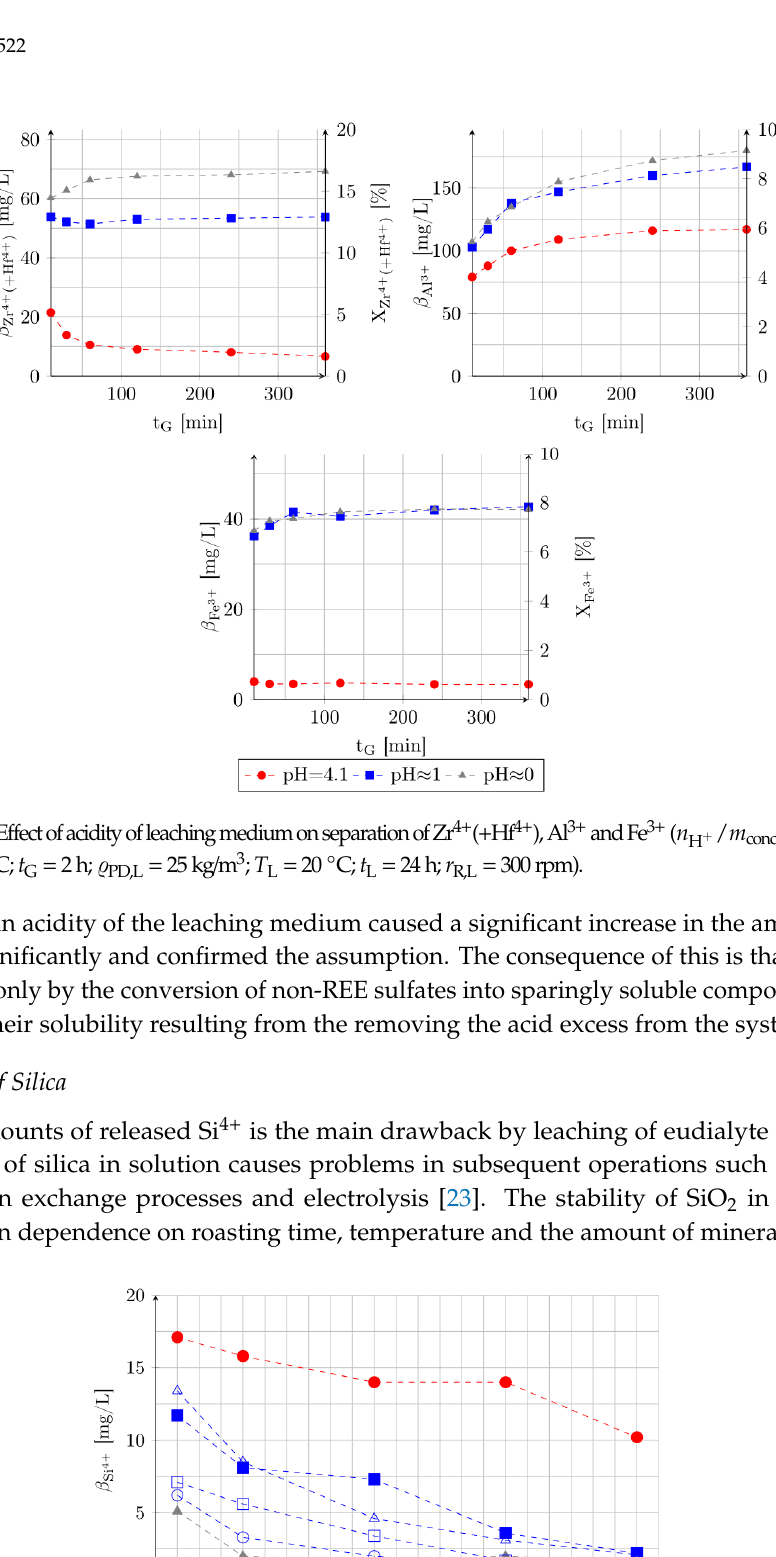
Figure 9. Effect of roasting time, roasting temperature and acid addition on the stability of SiO 2 ( ϱ PD,L = 25 kg/m 3 ; T L = 20 °C; t L = 24 h; r R,L = 300 rpm).